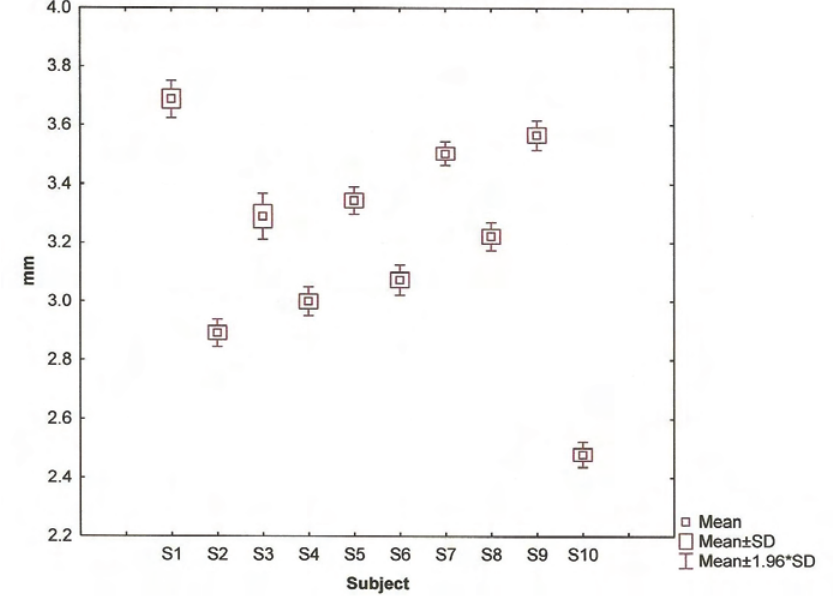
Figure 3. The box and whisker plots for measurements of axial anterior chamber depth (AACD) in millimeters ( y - axis) for the right eyes of the 10 subjects. The labels (S1 to S10) on the x -axis are the subject